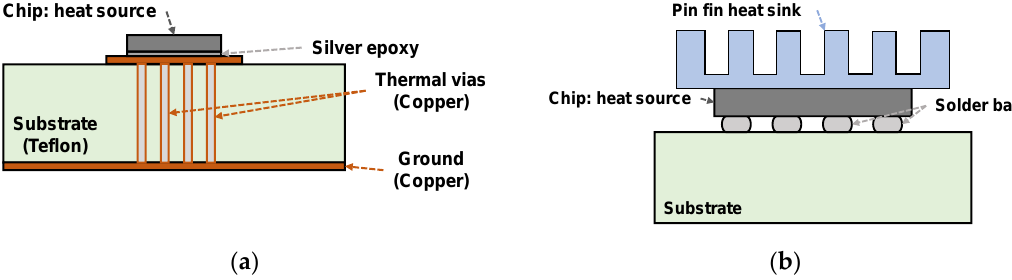
Figure 1. Previous methods to enhance thermal dissipation of the chip by ( a ) printed-circuit board (PCB) thermal vias and ( b ) direct heat sink attachment.